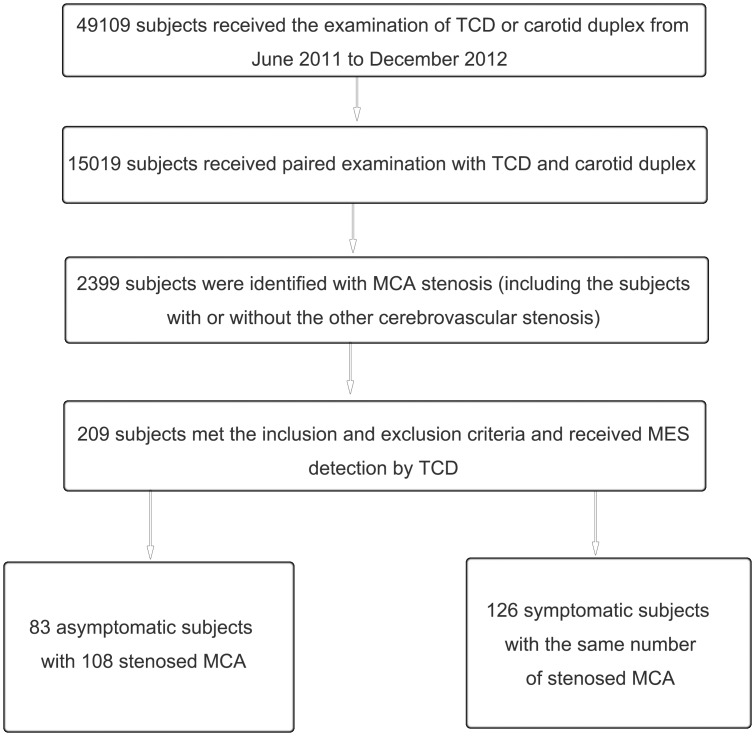
The flow chart of the study.TCD: transcranial Doppler sonography; MCA: middle cerebral artery.